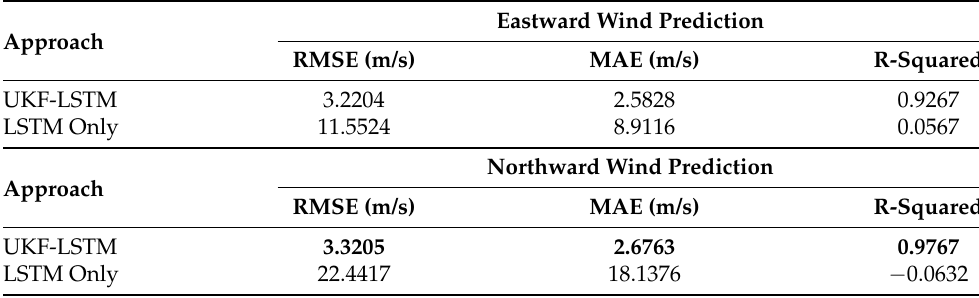
Table 4. Comparison of the proposed approach (i.e., UKF-LSTM) with the LSTM-only approach. Eastward Wind Prediction Approach RMSE (m/s) MAE (m/s) R-Squared UKF-LSTM 3.2204 2.5828 0.9267 LSTM Only Northward Wind Prediction Approach RMSE